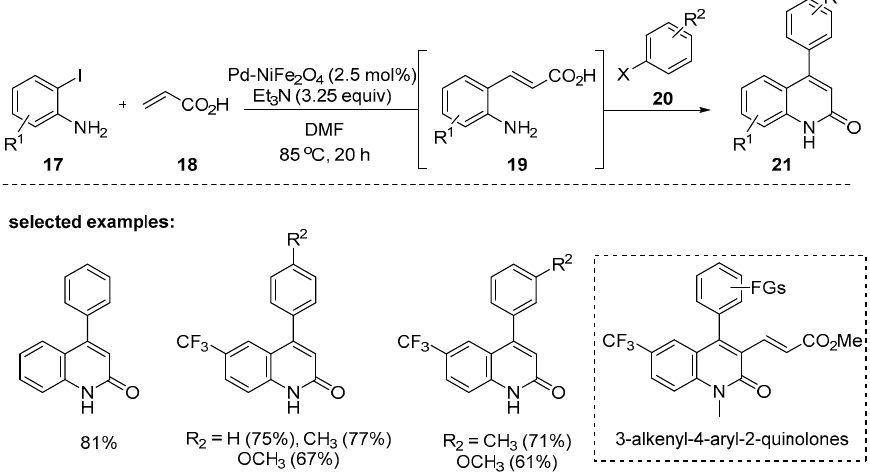
Scheme 4. Synthesis of 3-substituted 2-quinolones through a sequential Heck reaction/cyclization process of 2-iodoaniline 14 with dialkyl itaconates